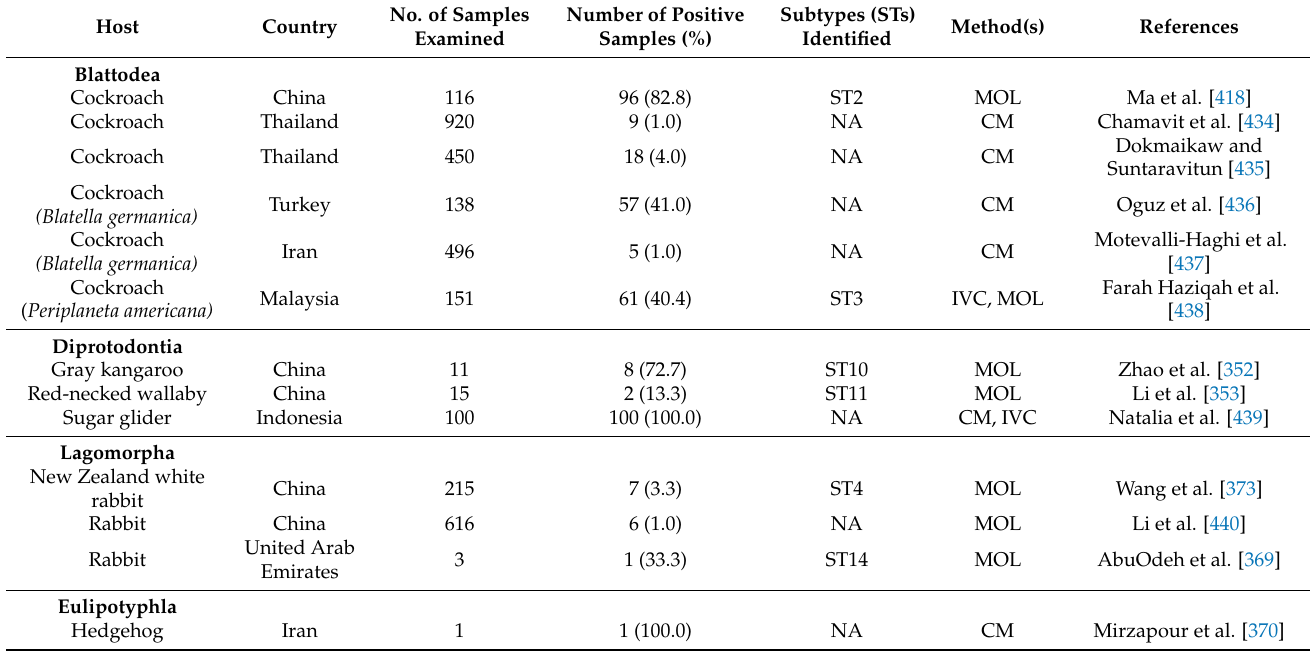
Table 15. Prevalence and subtype distribution of Blastocystis spp. in insects and other animal groups in Asia